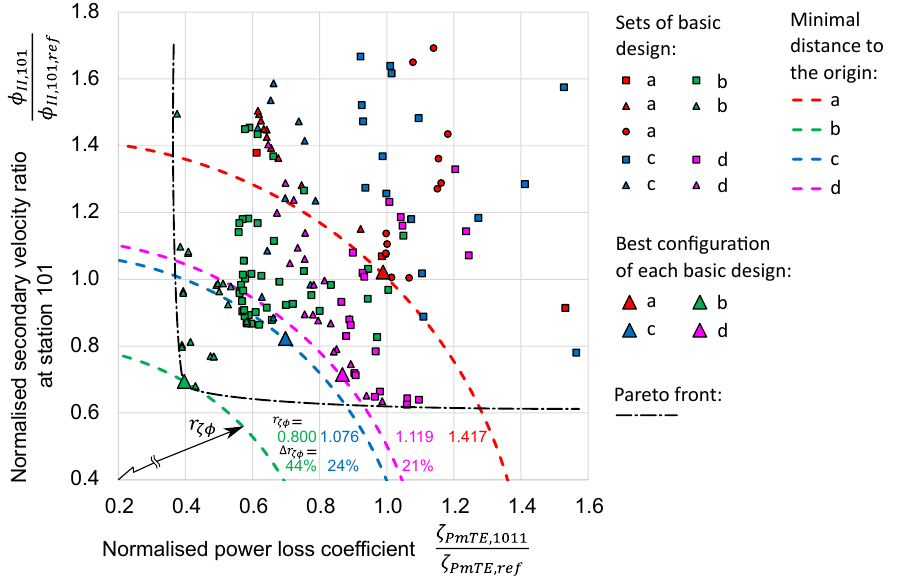
Figure 10. Scatter plot of normalised secondary velocity ratio at station 101 φ II ,101 against normalised φ II ,101, ref power loss coefficient ζ PmTE ,1011 . The best configuration of each of the four basic designs is marked ζ PmTE ,1011, ref by an enlarged triangle and the minimum distance of this point to the centre is indicated by dashed quarter circles. The Pareto front, linking all non-dominated design configurations, is sketched as a dash-dotted black